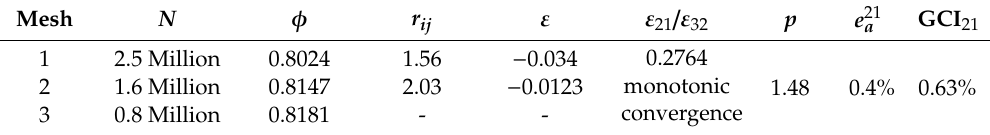
Figure 7. Longitudinal mesh cut.